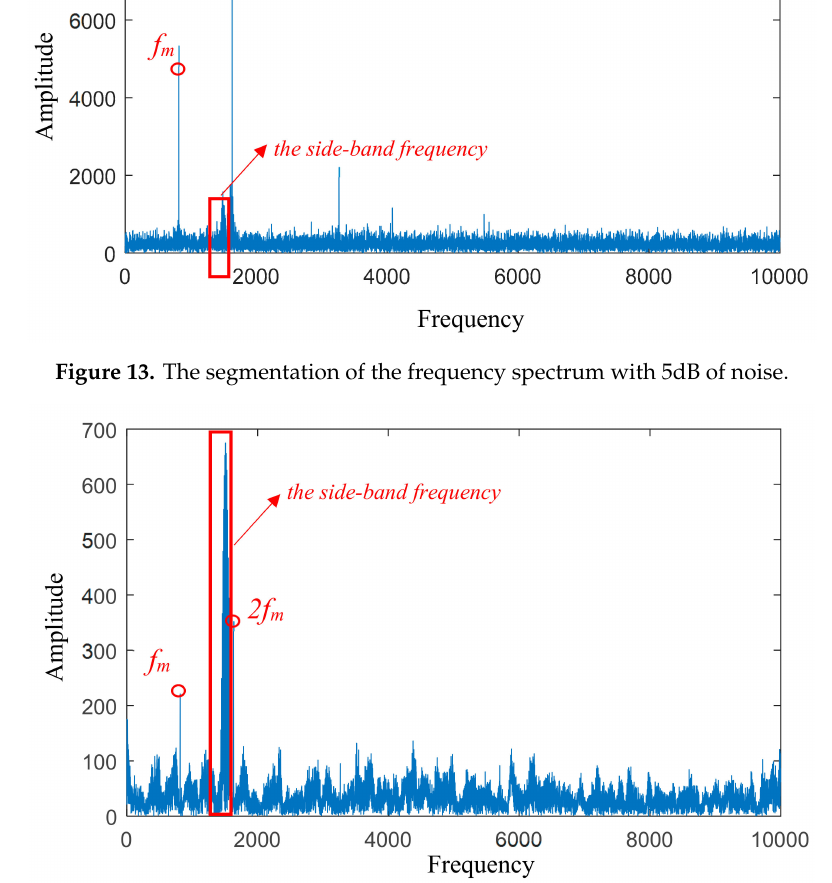
Figure 14. The segmentation of the frequency spectrum with spectral subtraction.